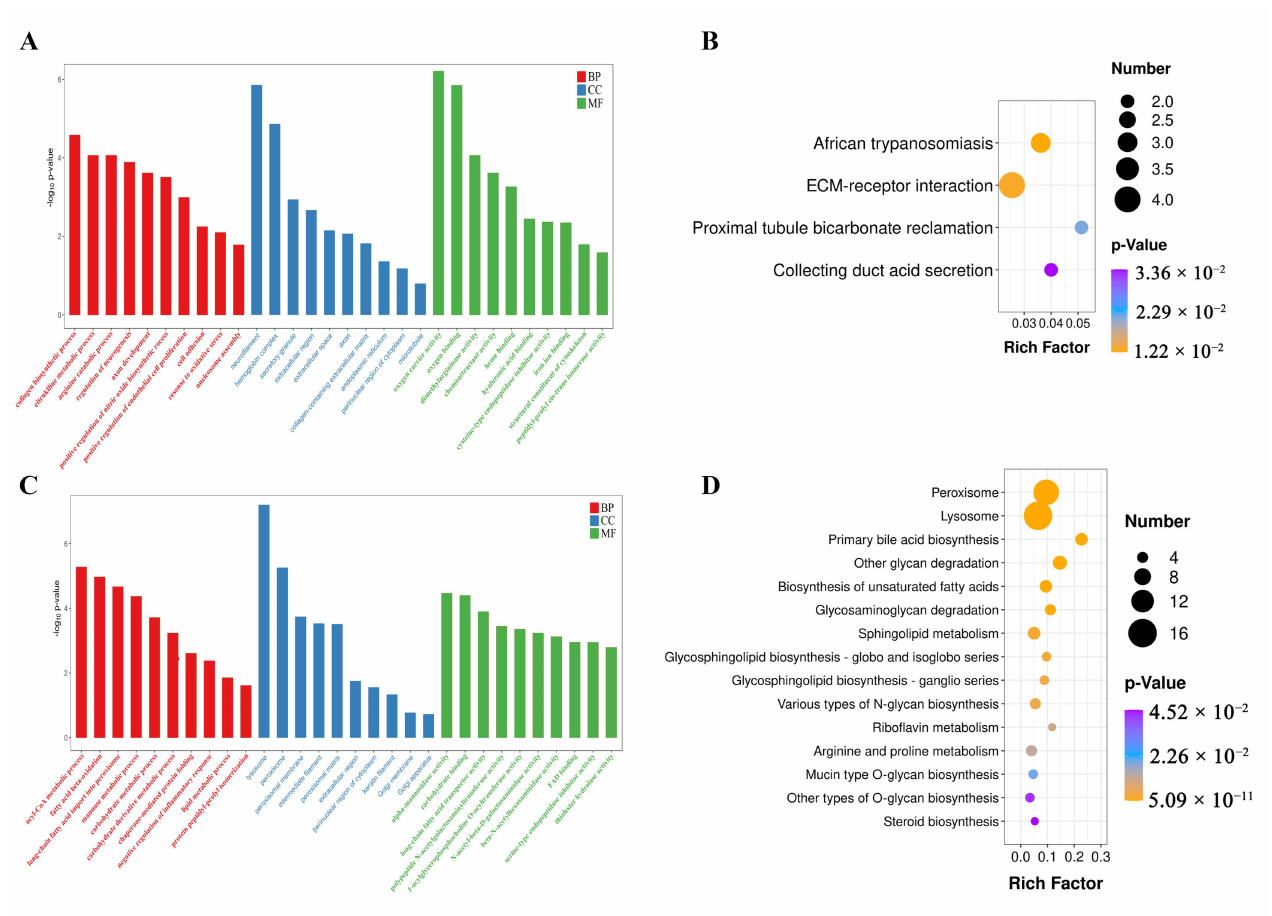
Figure 5. GO and KEGG enrichment analyses. ( A ) GO enrichment of upregulated DEPs. ( B ) KEGG enrichment analysis of upregulated DEPs. ( C , D ) GO and KEGG enrichment analyses of downregulated